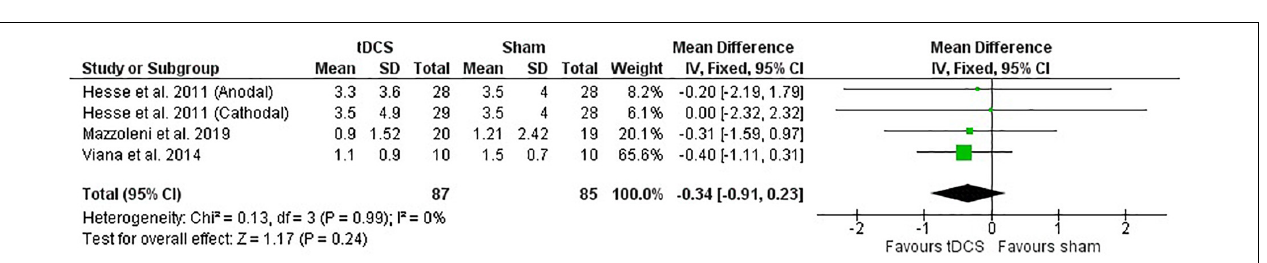
FIGURE 5 | Effects of tDCS on stroke recovery as assessed by the post-intervention results of the tDCS and sham groups for the Modified Ashworth Scale.